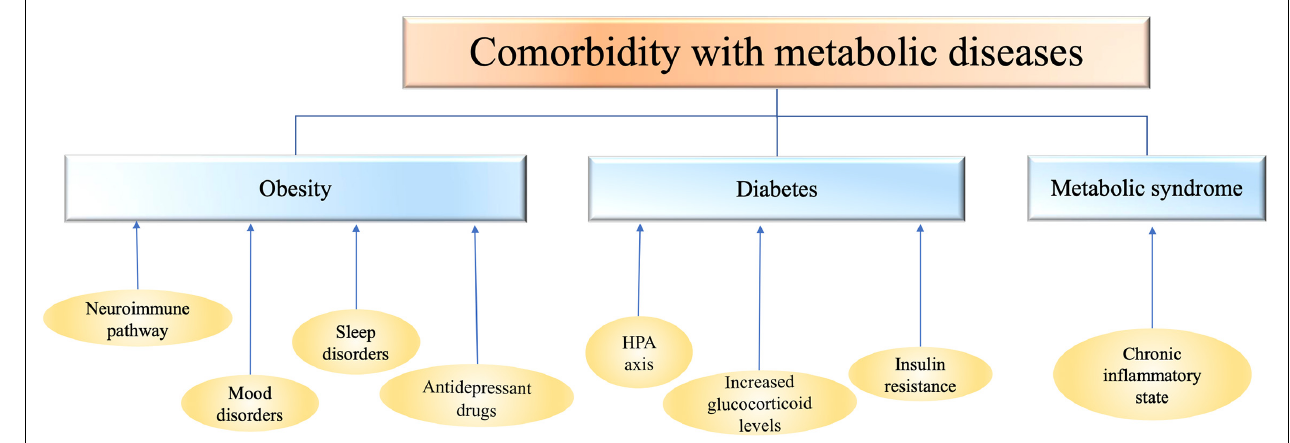
FIGURE 1 | Depression is comorbid with metabolic diseases such as obesity, diabetes, and metabolic syndrome. The mechanism of comorbidity is closely related to the abnormalities of inflammation, endocrine system, nervous system and immune system. HPA, hypothalamic-pituitary-adrenal axis.